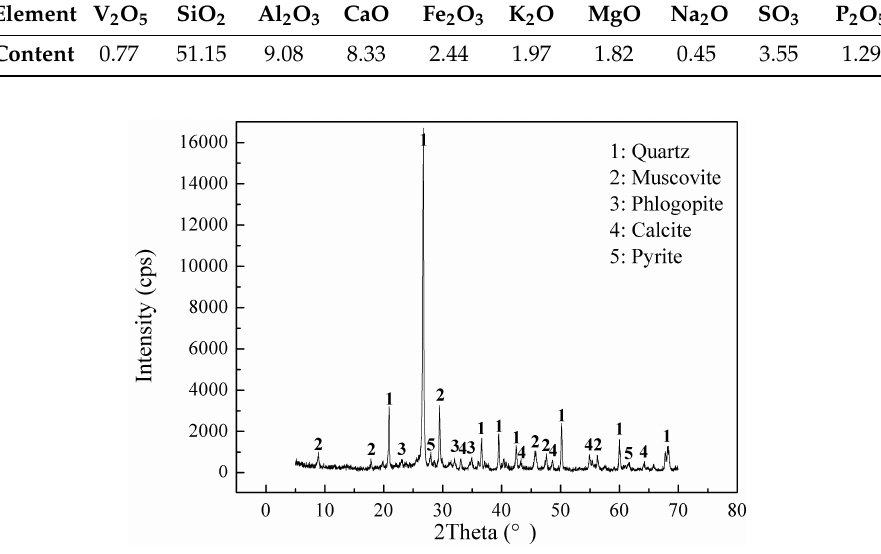
Table 1. Chemical multi-elemental analysis of stone coal wt % [16].